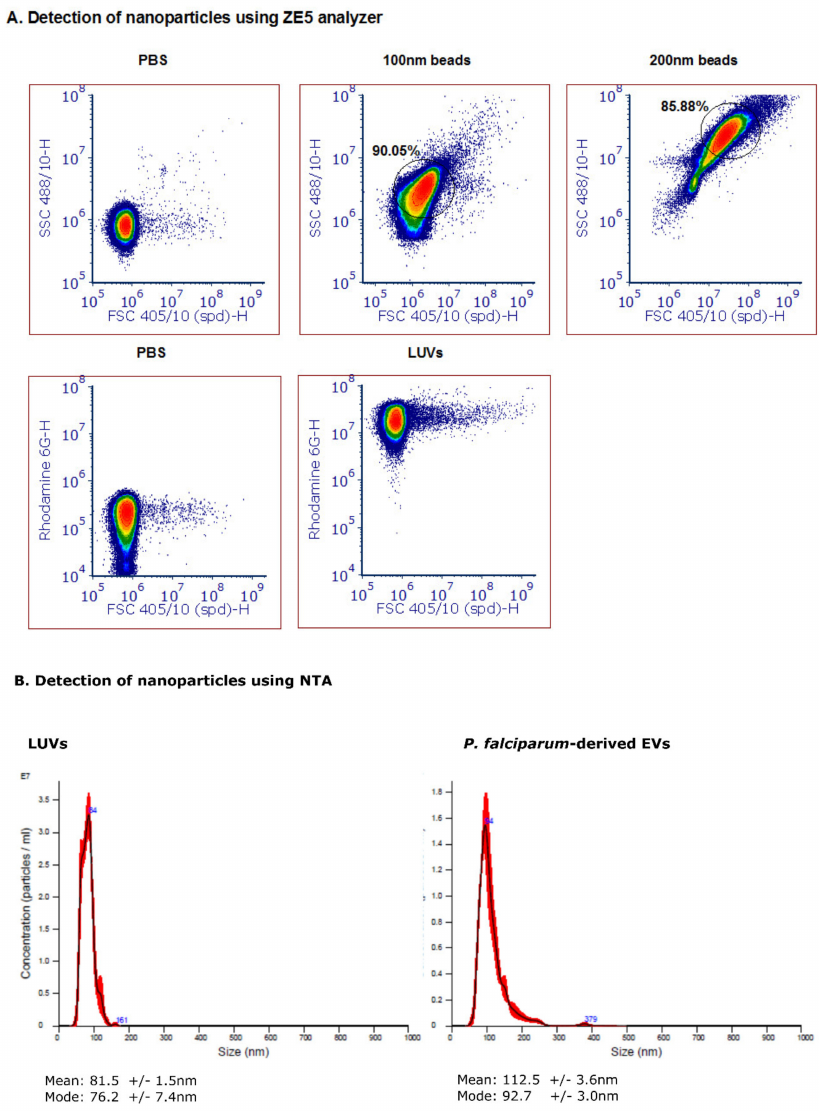
Figure 1. Detection of nanoparticles using the ZE5 analyzer and NTA analysis. ( A ) Polystyrene beads of 200 nm (top row, middle panel) and 100 nm (top row, right panel) in diameter were gated according to FSC 405 / 10 and SSC 488 / 10 light scattering. The analysis was visualized with a density plot and the gating was performed according to the main population. Rhodamine-PE large unilamellar vesicles (LUVs) were detected according to FSC 405 / 10 and the Rhodamine distribution. A PBS sample was used as control for undetected particles. ( B ) Nanoparticle tracking analysis (NTA) (Malvern Instruments Ltd., Nanosight NS300) was performed at 20 ◦ C on Rho-LUVs and EVs to determine the concentration and size. Sample size distributions were calibrated in a liquid suspension (1:1000 dilution) by the analysis of Brownian motion via light scattering. The camera level was set to 13 and the gain to 1, laser 405 nm or 488 nm without